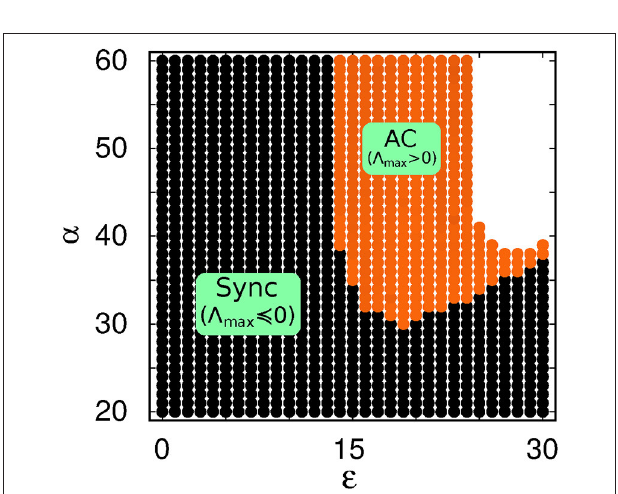
α space for P 10 ( ω 2). Three points at three α values at a particular ε − = = α space for ε 35. − =